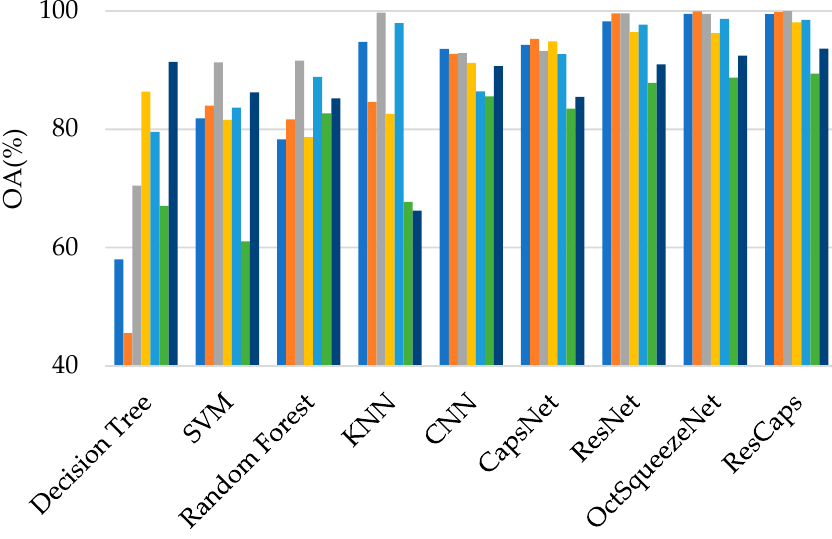
Figure 8. Classification results of different methods for each class on Bayview Park.